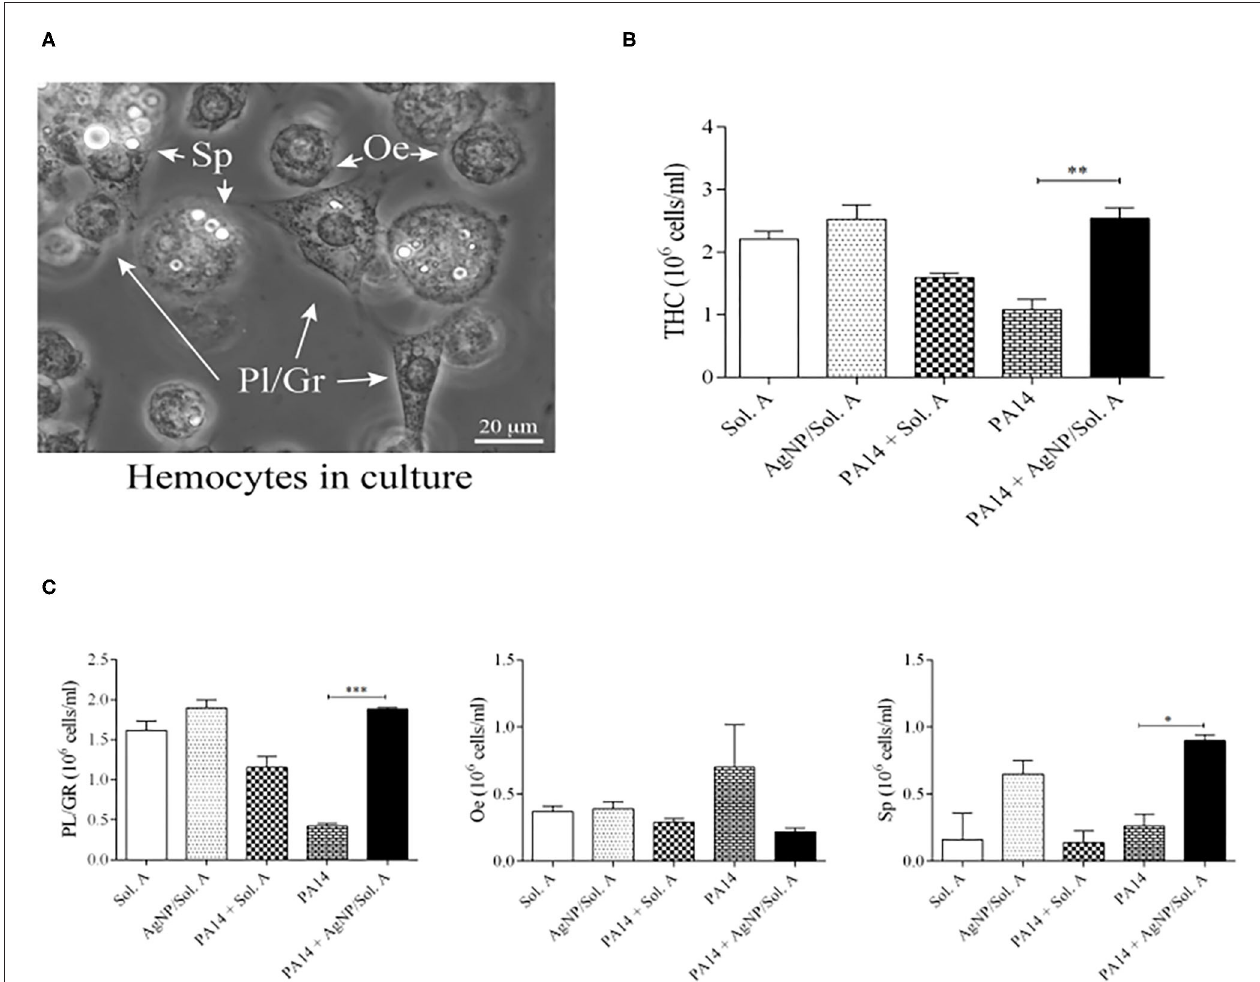
FIGURE 5 | (A) Microscopic images of Galleria mellonella hemocytes. Bar = 20 µ m. White arrowheads point to hemocytes, Pl/Gr, plasmatocytes/granular cells; Sp, spherulocytes, Oe, oenocytoids. (B) Total Hemocyte Count (THC) and (C) Differential Hemocyte Count (DHC) of circulating hemocytes in larvae prophylactically treated for 2 h with Solution A or AgNP/Sol. A and then infected for 18 h with P. aeruginosa cells. The first and second bars represent larvae treated with Sol. A and AgNP/Sol. A, respectively (negative controls). The third bar represents larvae infected with bacteria (PA14) in the presence of Sol. A. The fourth bar corresponds to larvae infected with bacteria suspended in saline and the fifth bar corresponds to larvae pre-treated with AgNP/Sol. A for 2 h and then challenged with bacteria. Each bar represents the mean and standard deviation of three independent experiments, 16 larvae were used in each condition. Asterisks denote statistically significant differences. ** p = 0.0041; *** p = 0.0003, and * p = 0.0116 (ANOVA and RM ANOVA followed by t -test).